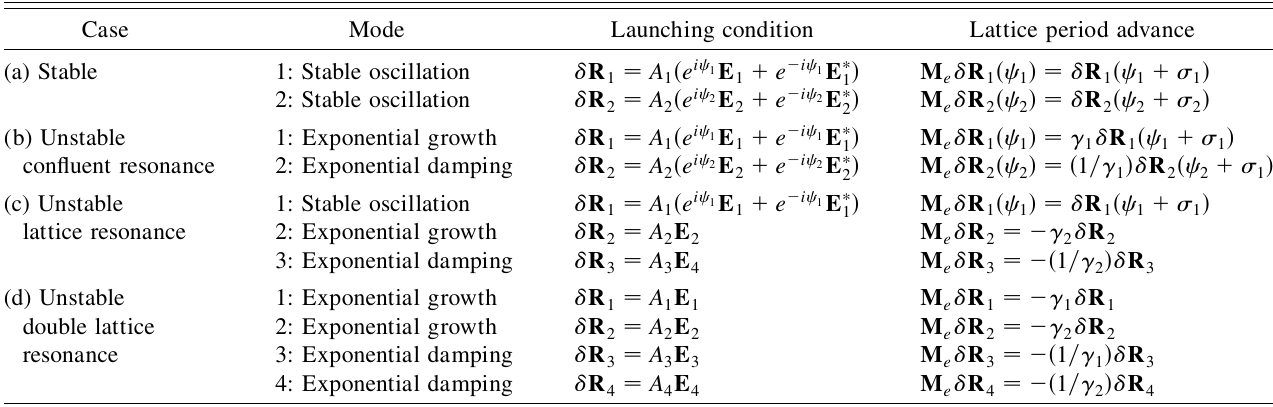
TABLE I. Launching conditions for distinct normal modes corresponding to the eigenvalue classes illustrated in Fig. 4. Here, A and are real-valued amplitudes (unnormalized) and phases of mode ‘ ( ‘ (cid:1) 1 , 2, and possibly 3 and 4 under conventions taken), ‘ > 1 are the phase advances and growth factors of the mode over one lattice period. Symbols are abbreviated and (cid:6) and (cid:24) ‘ ‘